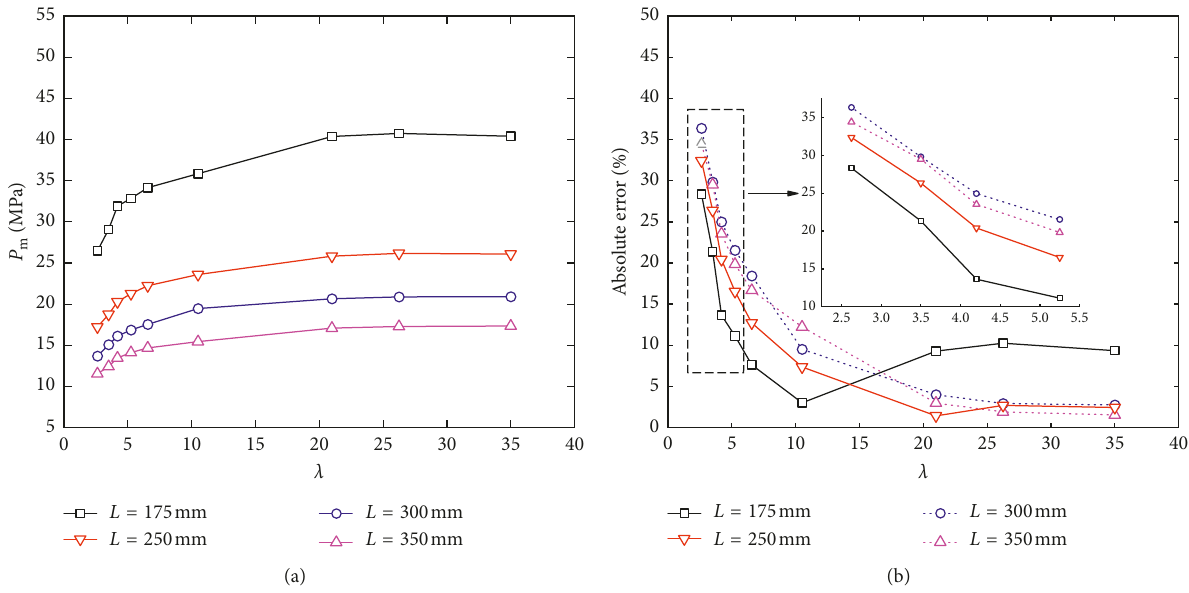
Figure 14: (a) P m with λ at different standoff distances L and (b) absolute error of P m .